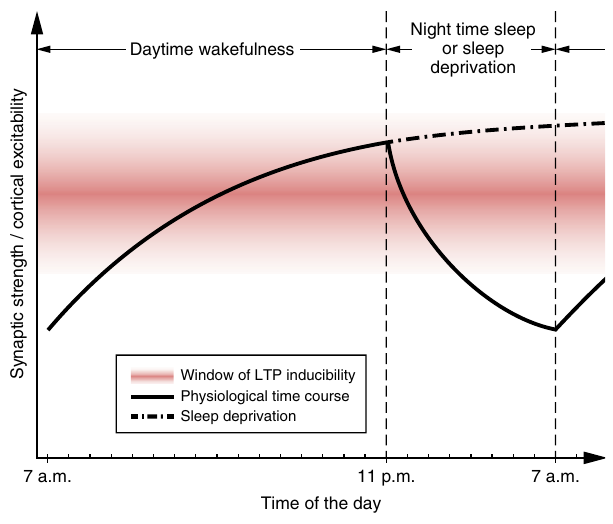
Figure 5 | ‘Happy medium’ model of LTP inducibility across the sleep wake cycle. The figure depicts the proposed interplay between the time course of synaptic strength/cortical excitability (homeostatic plasticity; solid and dotted lines) and the inducibility of associative synaptic long-term potentiation (LTP)-like plasticity (red window). Wakefulness is associated with an upscaling and sleep with a downscaling of net synaptic strength. Sleep deprivation eventually leads to synaptic saturation and deficient LTP